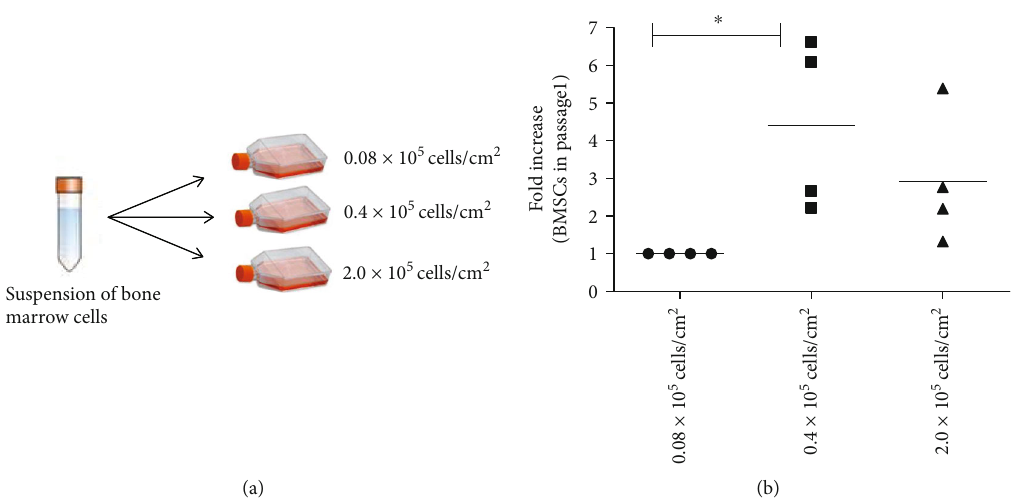
Figure 1: Standardization of cell isolation. (a) Schematic representation of the protocol used for determining the optimal initial seeding densities. (b) Fold increase in cell number (BMSCs in passage 1). n = 4 ; p = 0 : 015 .